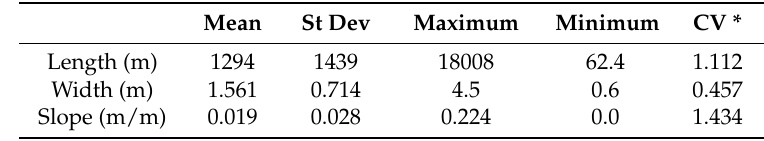
Table 1. Descriptive statistics of individual